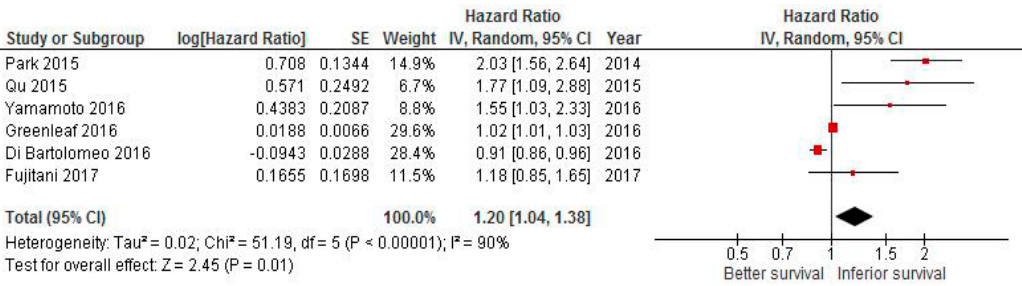
Figure 2. Forest plot of association between delay of adjuvant chemotherapy beyond 6–8 weeks and survival in gastric cancer.